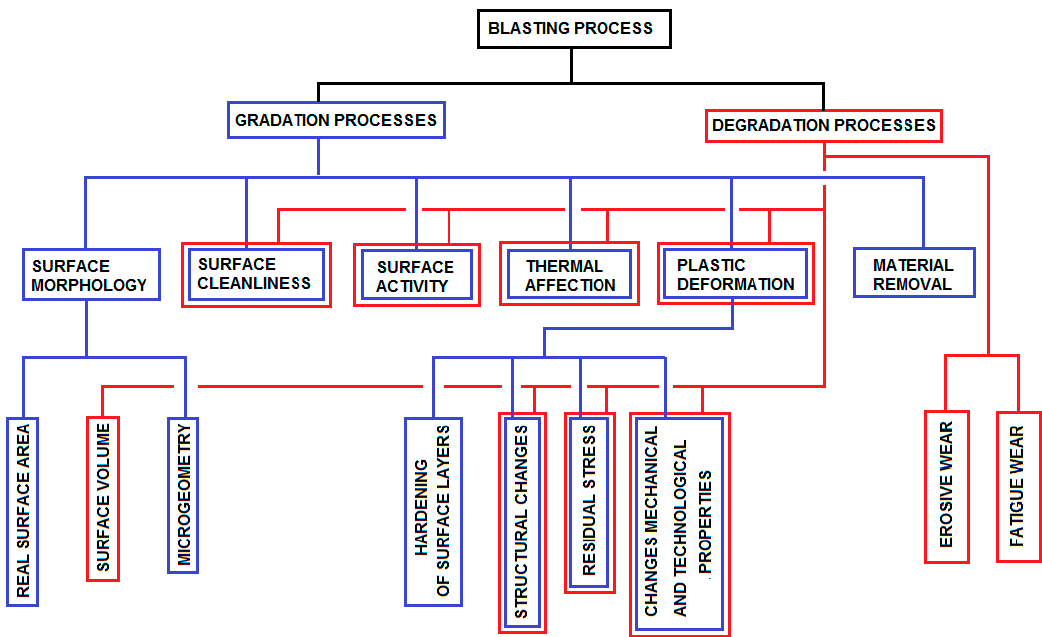
Figure 1. The schematic classification of blasting effects on the substrate.